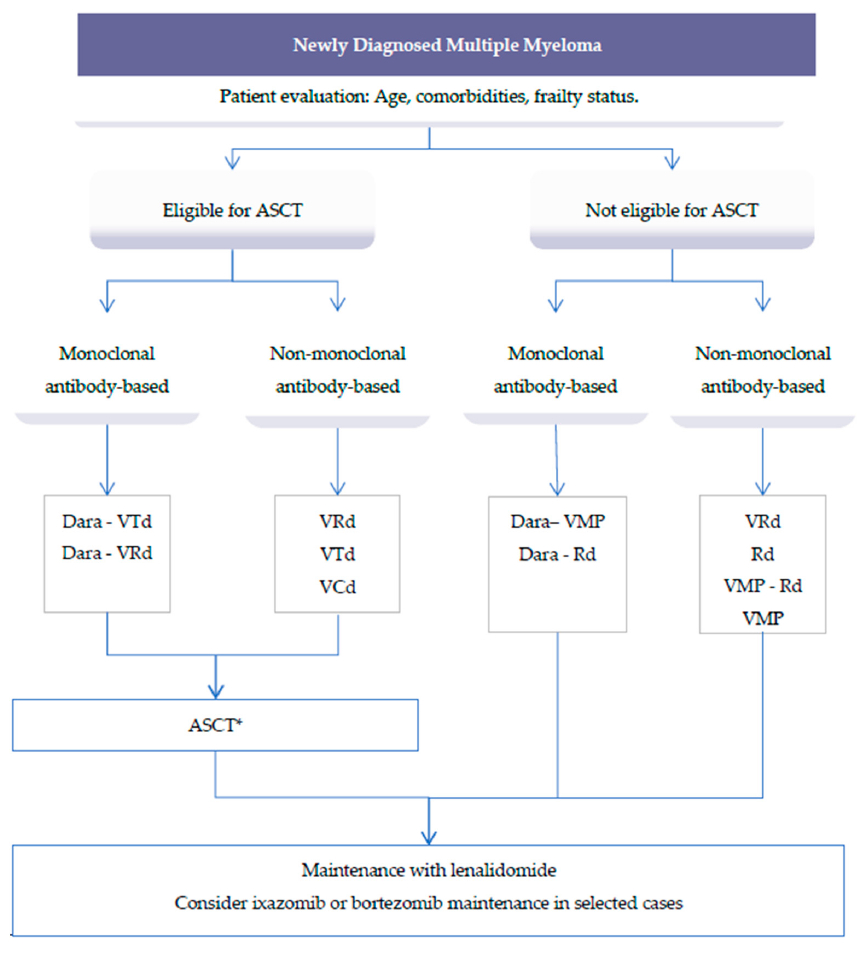
Figure 1. Suggested treatment options for newly diagnosed multiple myeloma (MM) patients. * Consider tandem ASCT in eligible high-risk patients. Abbreviations: ASCT: Autologous stem cell transplant; Dara: Daratumumab; VTd: Bortezomib, thalidomide, dexamethasone; VRd: Bortezomib,